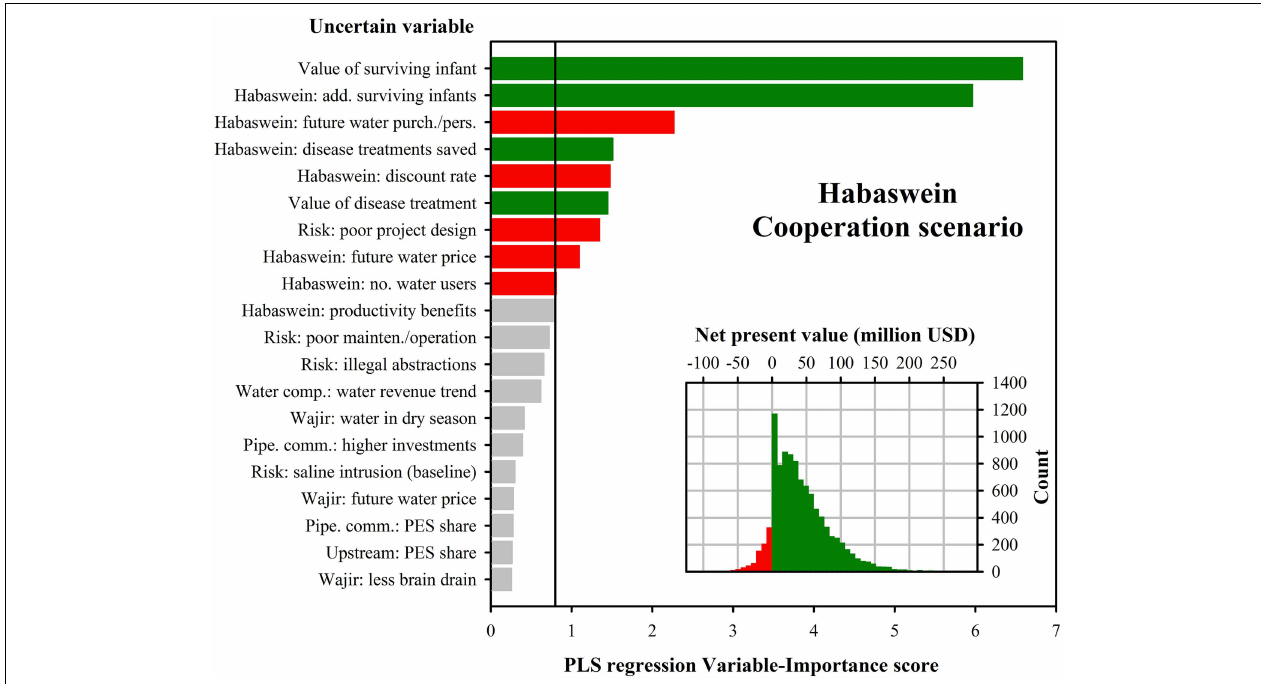
FIGURE 8 | Key sources of uncertainty in projecting outcomes for the residents of Habaswein for the “cooperation” scenario, as identified by Partial Least Squares (PLS) regression. For a details description of the plots, see legend to Figure 5 .